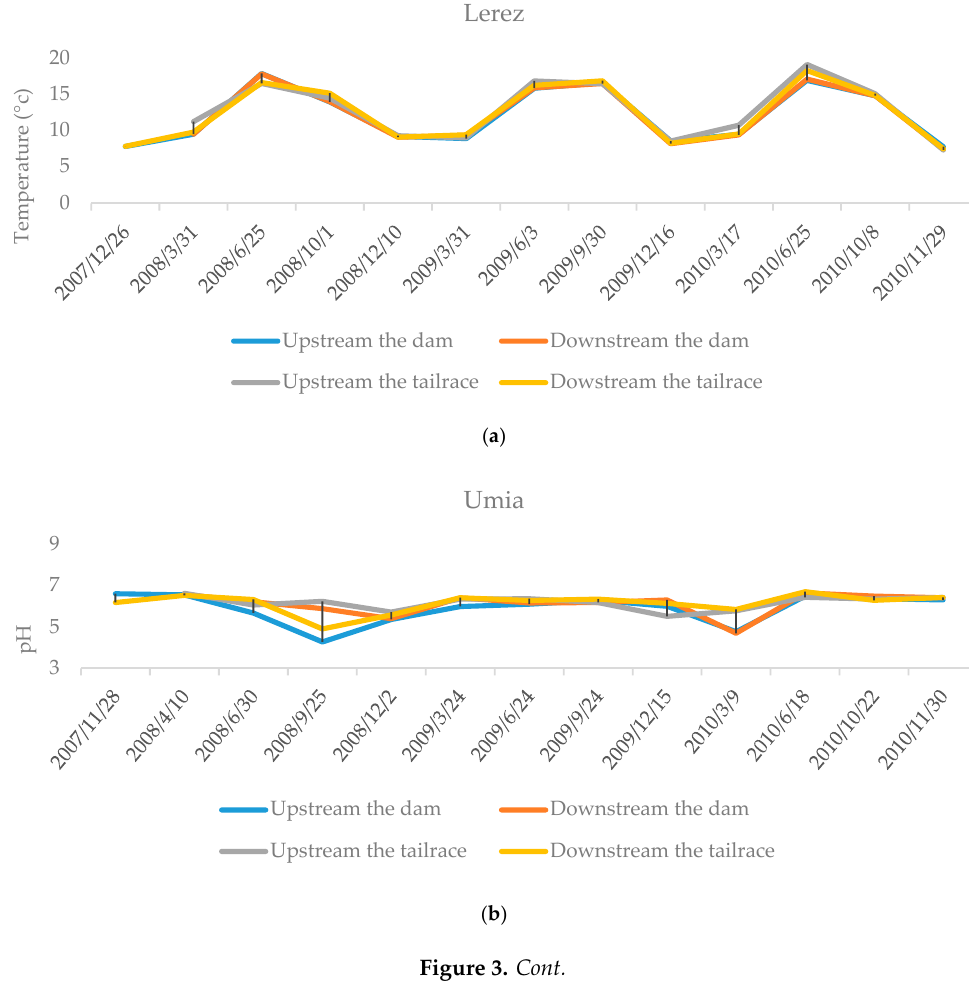
Table 2. Reference Condition in Cantabric-Atlantic siliceous rivers.